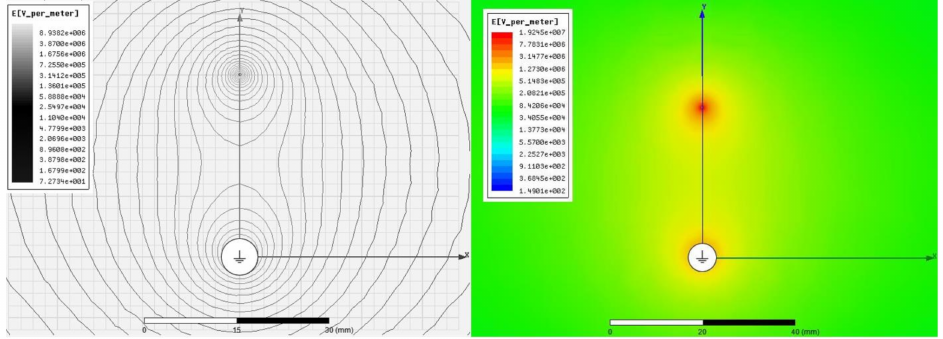
Figure 9. Single thruster, electric field (absolute value of E).